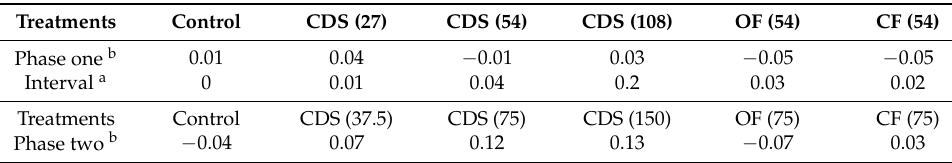
Figure 2. TN in soil affected by application of co-digestion sludge (( a ): phase one, ( b ): phase two). Table 6. Soil TN loss of the treatments in phase one and two (g/kg).